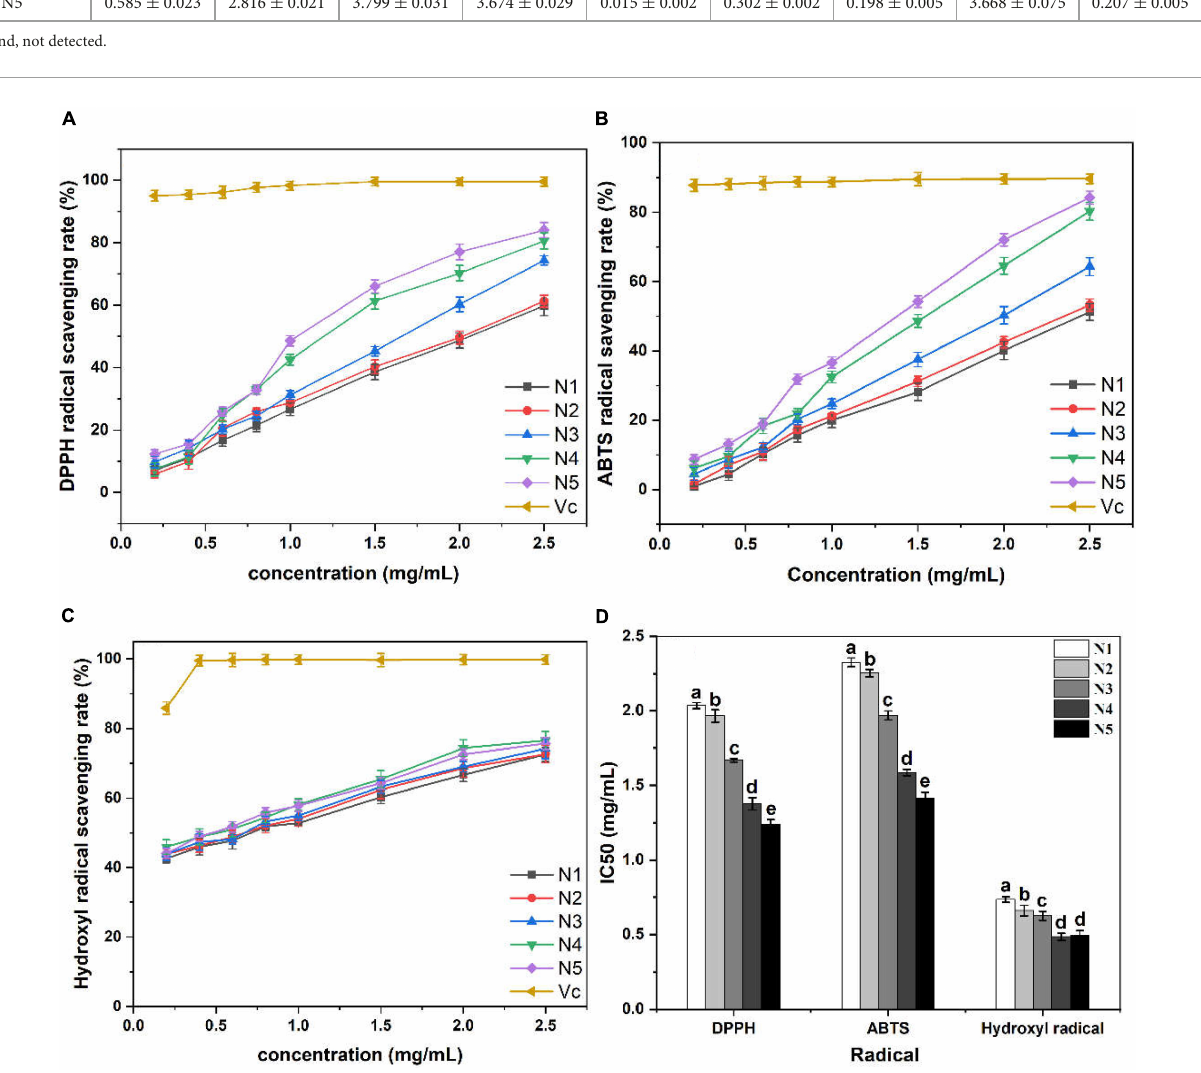
FIGURE3 Scavenging activity of Noni polysaccharide samples on DPPH (A,D) , ABTS (B,D) , and hydroxyl radical (C,D) . Data marked with different letters are significantly different at p < 0.05.